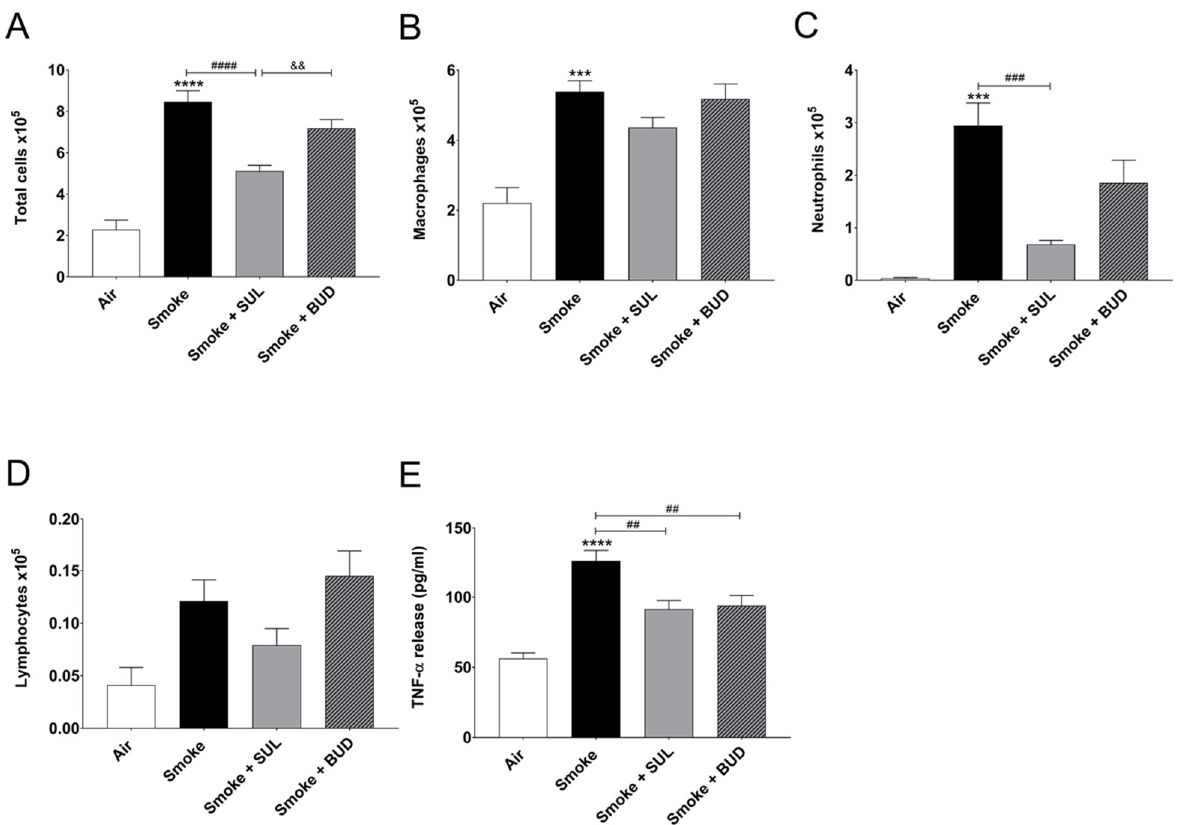
Figure 2. Prophylactic SUL-151 administration prevents pulmonary inflammation in a CS exposure model. Mice were exposed to CS for 5 days (twice/day) and received SUL-151 or budesonide via oropharyngeal administration (once/day) 30 min before the first-time smoke exposure during these 5 days. On day 6, lungs were lavaged, and BALF was collected for total ( A ) and differential BALF cell counts, including macrophages ( B ), neutrophils ( C ), and lymphocytes ( D ), and TNF- α levels ( E ) were measured in BALF. Values are expressed as mean ± SEM. *** p < 0.001, **** p < 0.0001, smoke group compared to air group; ## p < 0.01, ### p < 0.001, #### p < 0.0001, smoke + SUL group or smoke + budesonide (BUD) group compared to smoke group; && p < 0.01, smoke + BUD group compared to smoke + SUL group. n = 4–8 mice/group.